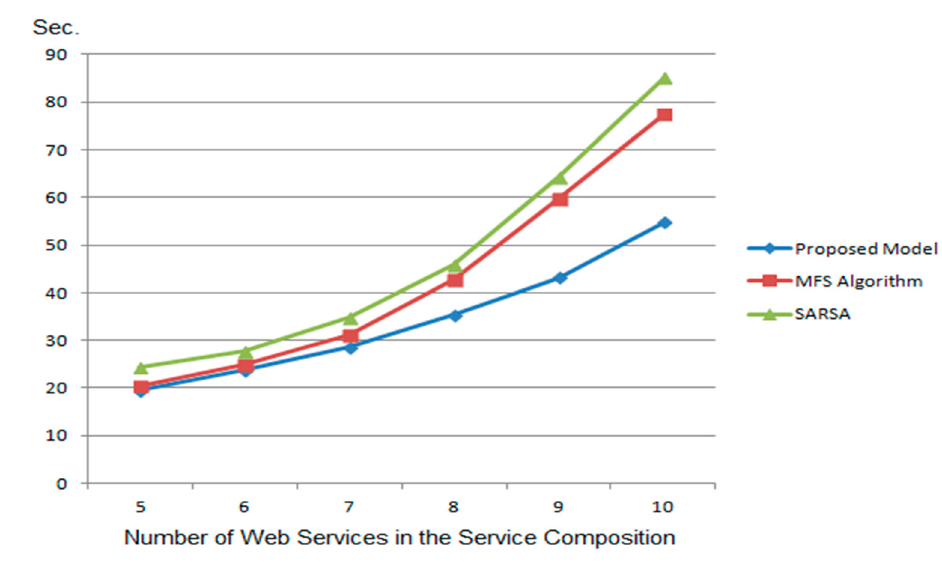
Figure 4. Service composition construction time when the composition threshold = 200.